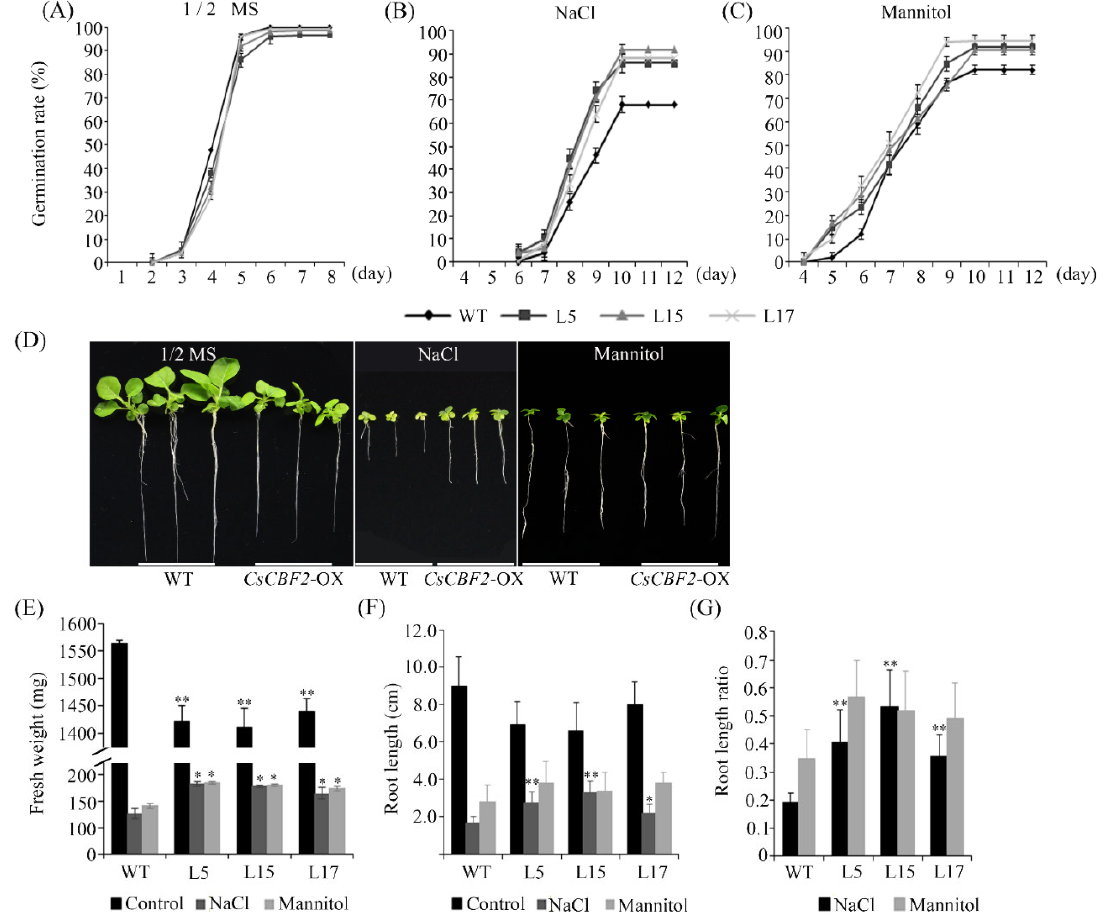
Figure 7. Phenotypic and physiological responses of CsCBF2 -overexpressing transgenic plants under salt and drought stress conditions. Data are means ± standard deviation (SD) of three independent experiments. Significant differences between WT and transgenic plants under control and stress conditions are indicated by * p < 0.05, ** p < 0.01; Student’s t -test. ( A – C ) respectively show the germination rate of WT and CsCBF2- OX L5, L15, L17 growing on 1/2 MS culture medium, on 1/2 MS culture medium with 150 mM NaCl, on 1/2 MS culture medium with 400 mM mannitol. ( D ) The phenotype of WT and CsCBF2- OX growing on 1/2 MS culture medium, on 1/2 MS culture medium with 200 mM NaCl, on 1/2 MS culture medium with 200 mM mannitol. ( E ) The fresh weight of WT and CsCBF2- OX L5, L15, L17 under normal conditions (control), salt stress, and high concentration of mannitol simulated drought stress for 20 days. ( F ) Root length of WT and CsCBF2- OX L5, L15,